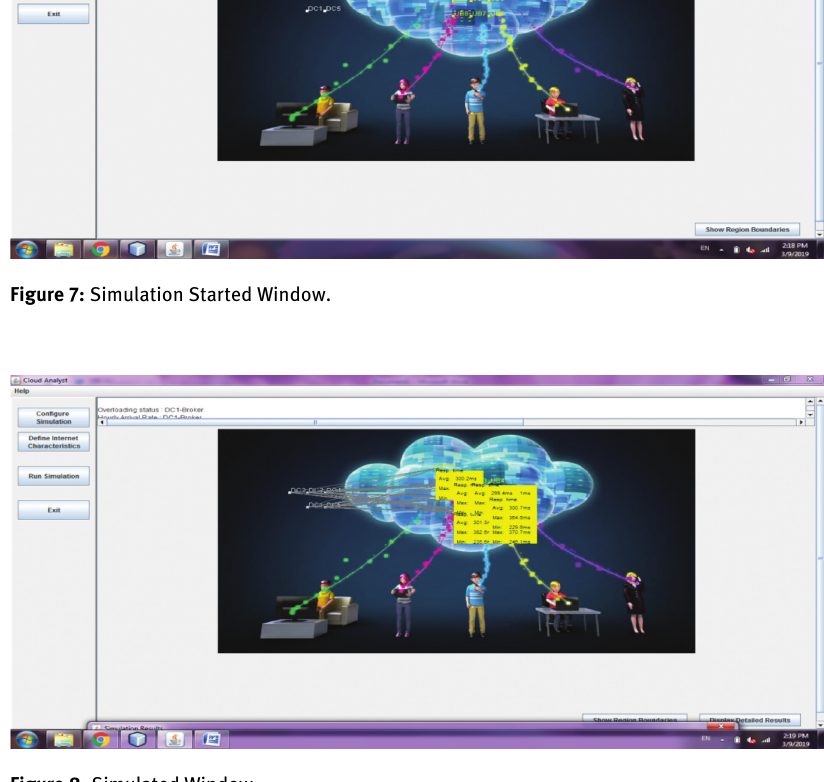
Figure 8: Simulated Window.